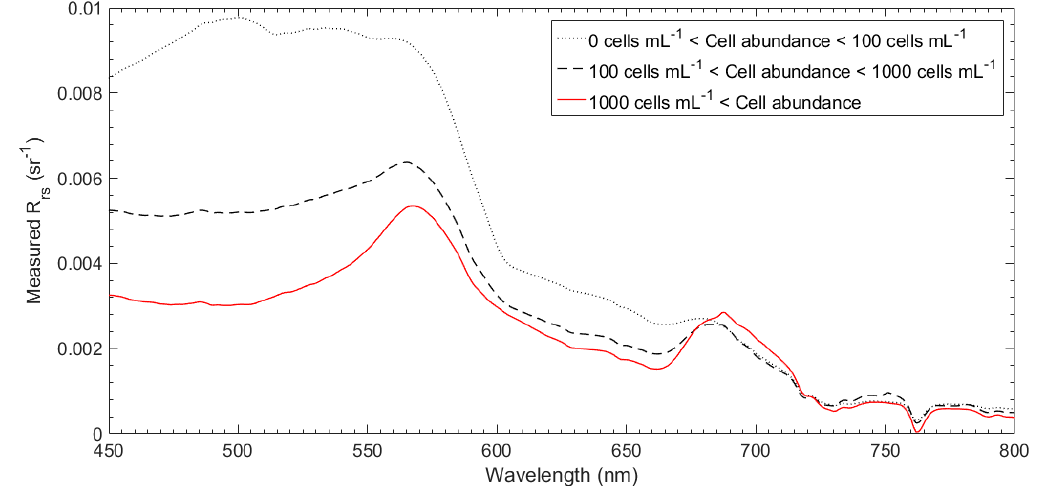
Figure 7. Average spectra of in situ R rs with a range of M. polykrikoides cell abundance. The black dotted line represents cell abundance of 100 cells mL − 1 or less. The black dashed line and red line indicate M . polykrikoides cell abundances above 100 and 1000 cells mL − 1 , respectively.